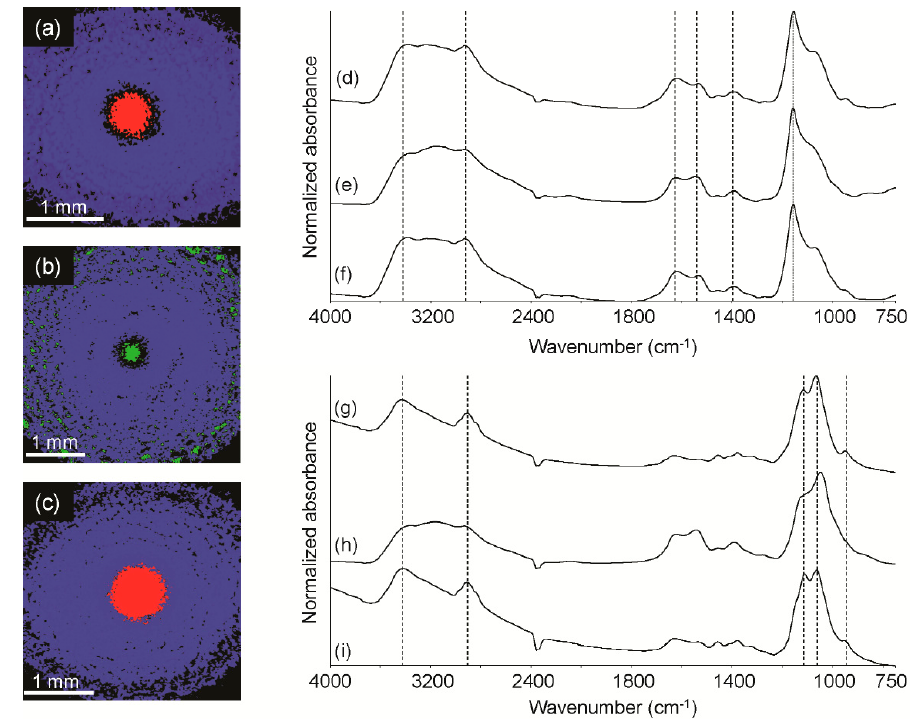
Figure 5. Reflection/absorption-IR images of the suspect dried residue ( a ); control dried residue ( b ) and control spiked with bleach dried residue ( c ); representative spectra from the blue region in the suspect image ( d ); control image ( e ) and control spiked with bleach image ( f ); representative spectra from the red region in the suspect image ( g ); green region in the control image ( h ) and red region in the control spiked with bleach image ( i ).